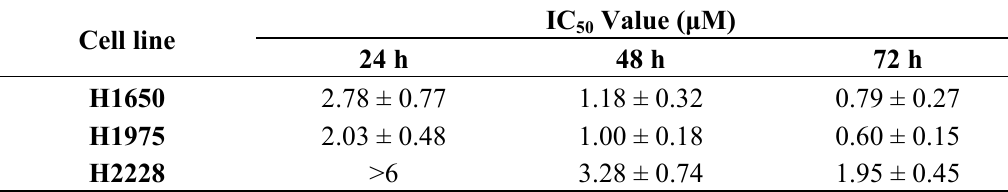
values of celastrol on three NSCLC cell Table 1. The IC 50